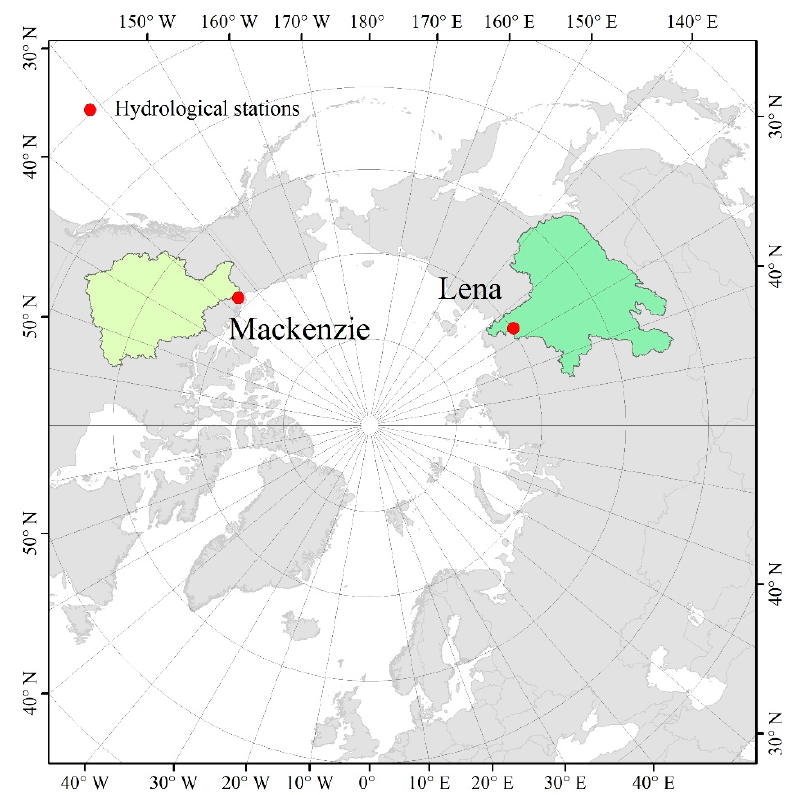
Figure 1. The study areas include the Mackenzie River Basin (MRB) and the Lena River Basin (LRB). Red dots represent the hydrological stations for observation. Permafrost distributions and major water bodies are also displayed.